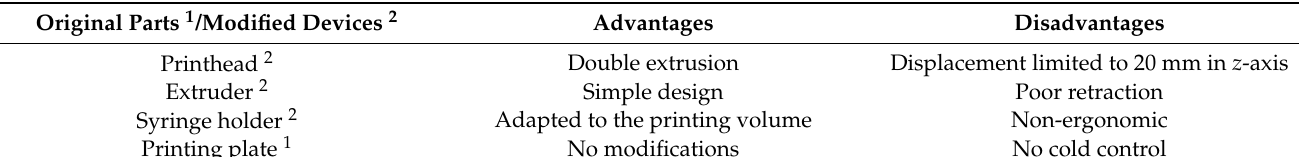
Table 2. Main advantages and disadvantages of the first printhead prototype developed from the